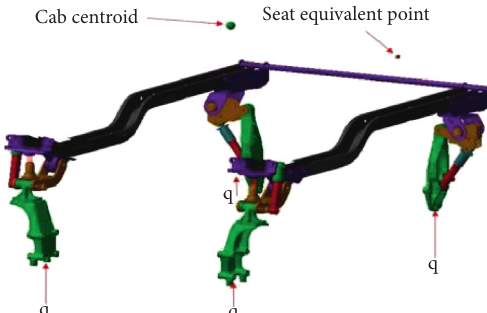
Figure 11: Simplified cab suspension combination